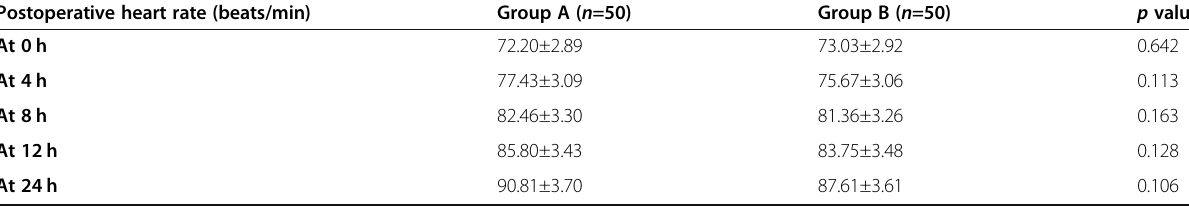
Table 3 Difference between group A and group B according to postoperative heart rate (beat/min) Postoperative heart rate (beats/min)